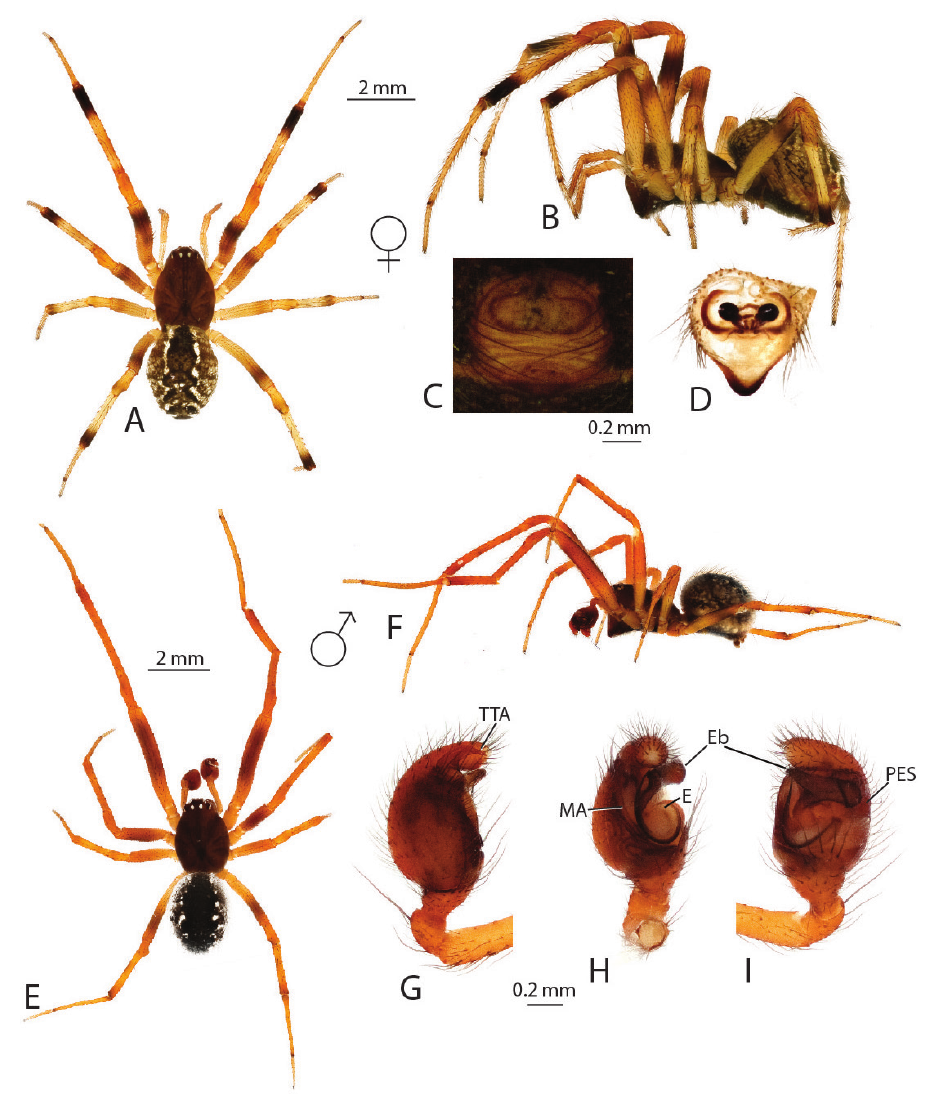
Figure 3. Anelosimus vondrona : A–B female dorsal, lateral C epigynum ventral view D epigynum, dorsal E–F male dorsal, lateral G–I male palp mesal, ectal,